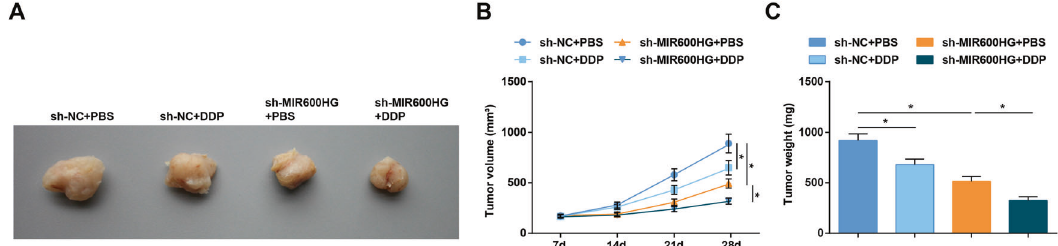
Fig. 7 Silencing of MIR600HG strengthens the DDP sensitivity of OSCC cells in vivo. A Representative images of xenografts from nude mice; B tumor volume of each group; C tumor weight of each group; n = 6; * P < 0.05; the data were expressed as mean ± standard deviation and ANOVA was used to analyze